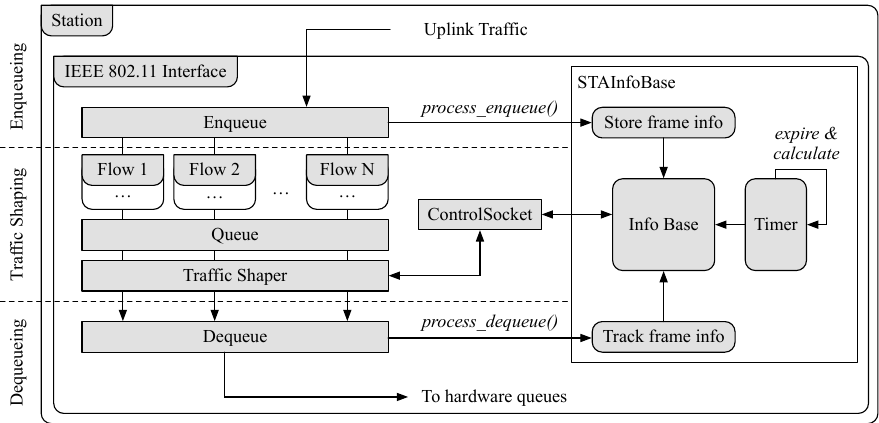
Figure 5. Traffic shaping in the simplified queue structure and data flow in an Station